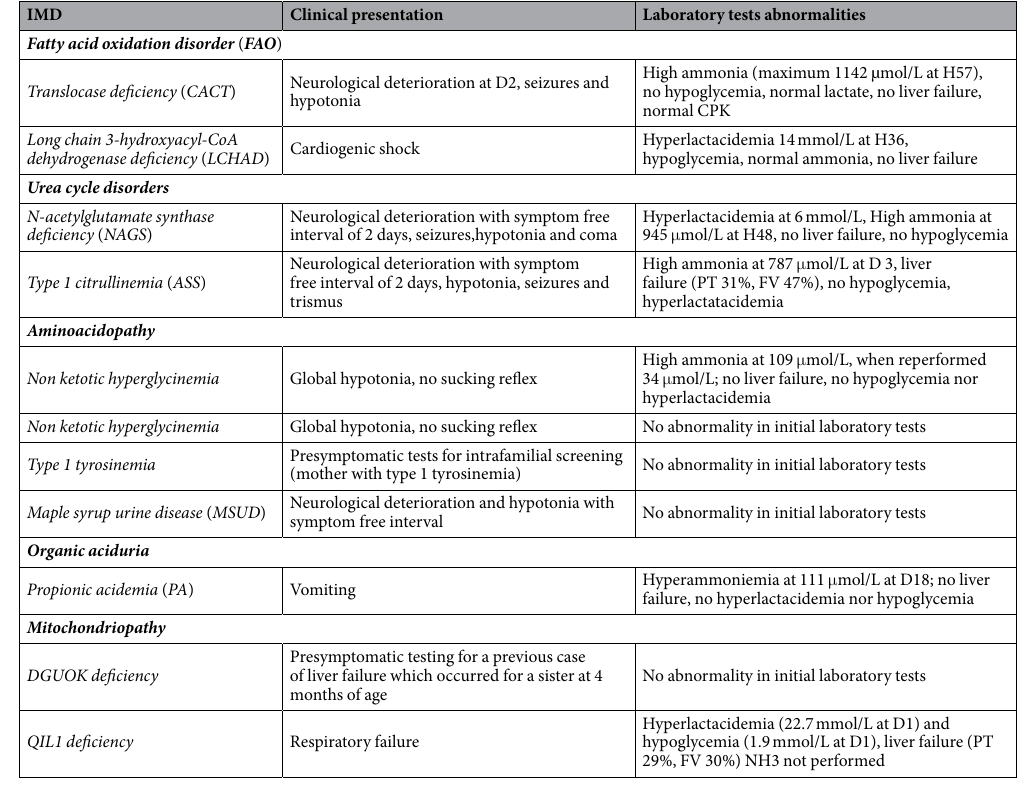
Table 8 . Clinical presentation and initial laboratory parameters of IMD patients. Clinical presentation and initial laboratory parameters of the identified cases of IMD. NP: not